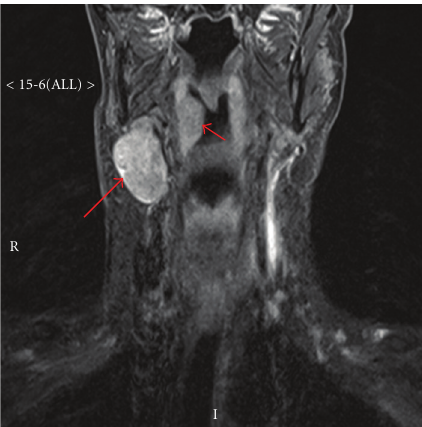
Figure 1: MRI of the neck showing an enlarged lymph node (long arrow) and a bulge in the right tonsillar fossa (short arrow) suspicious for primary tumour.